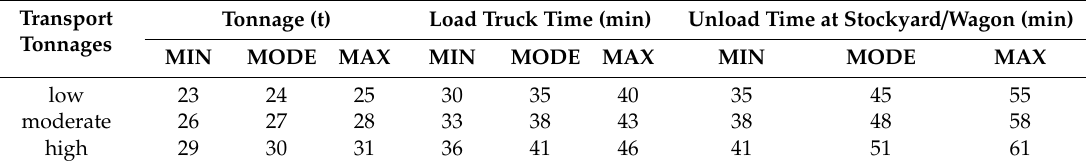
Table 3. Truck tonnages and dependent process